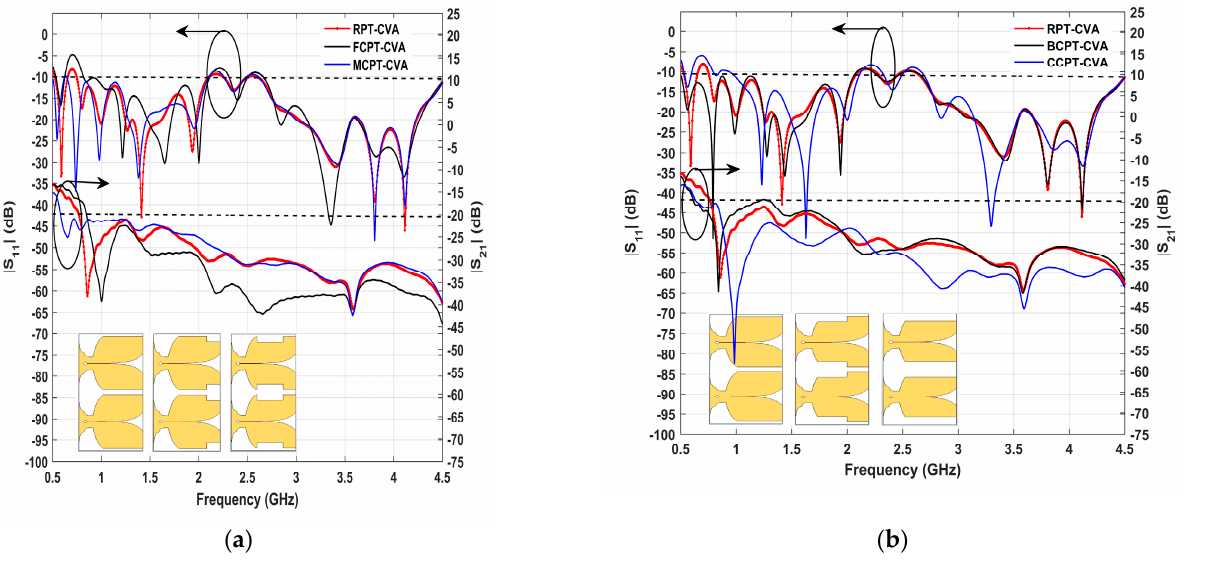
Figure 3. S 11 and S 21 performance of 1 × 2 MIMO ( a ). Regular Palm Tree Coplanar Vivaldi Antena (RPT – CVA), Front Cut Palm Tree (FCPT – CVA), Middle Cut Palm Tree (MCPT – CVA), and ( b ). S 11 and S 21 of Regular Palm Tree Coplanar Vivaldi Antena (RPT ̶ CVA), Back Cut Palm Tree (BCPT – CVA), Complete Cut Palm Tree (CCPT – CVA).